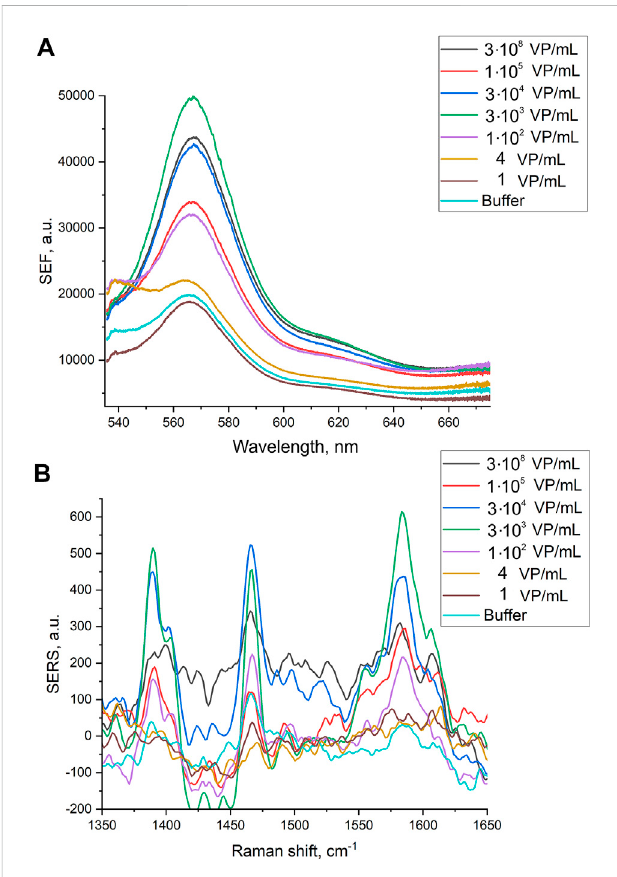
Surface-enhanced fl uorescence (A) and surface-enhanced Raman (B) spectra of Cyanine-3 reporter obtained from the track-etched membranes functionalized with the aptamer after the fi ltration of the probes with different concentrations of in fl uenza A